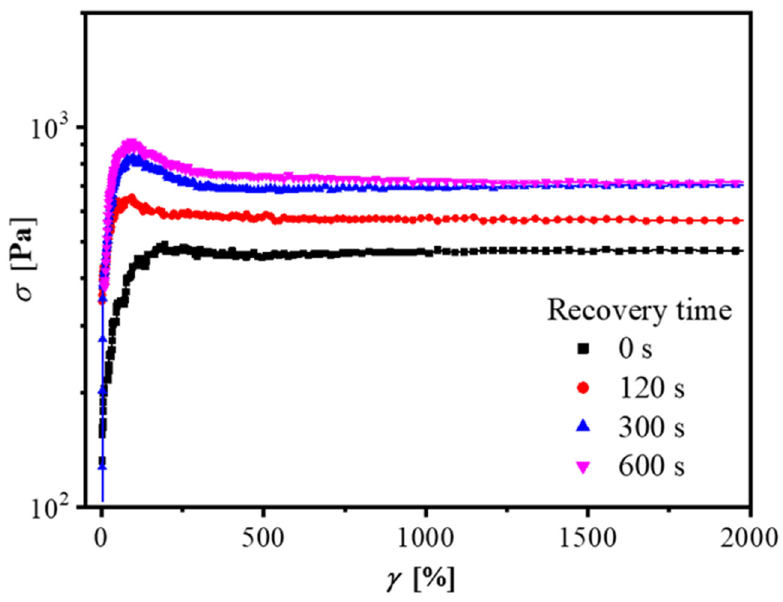
Figure 5. Transient stress response for HTPB28/C18-clay 8 wt% with different recovery times in the reverse flow at 60 °C. A shear rate of 10 s − 1 was chosen.